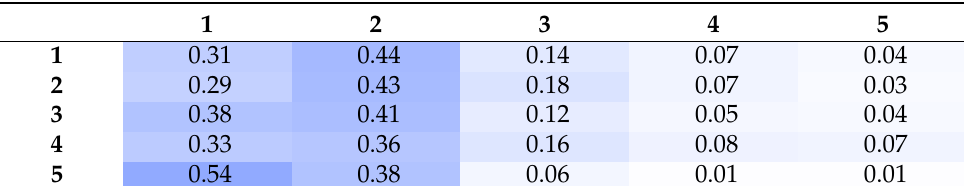
Table 7. Transition probability matrix: direction to speed.